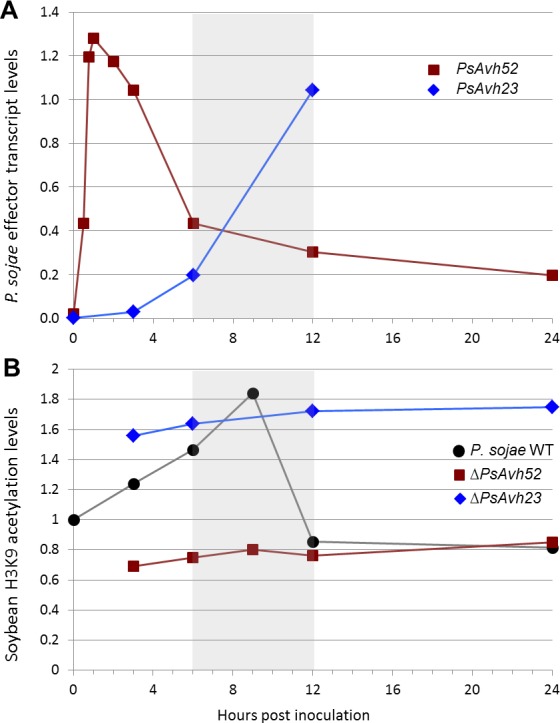
Expression patterns of PsAvh52 and PsAvh23 correlate with changes in soybean histone H3 acetylation during P.sojae infection.(A) Transcript levels of PsAvh52 and PsAvh23 relative to a basket of constitutive reference genes, during P. sojae infection of soybean hypocotyls. Data are adapted from Figure 5 of Wang et al., 2011 and Figure 8C of Ma et al., 2015. (B) Soybean histone H3K9 acetylation levels during infection of soybean hypocotyls by P. sojae wildtype P6497, and by strains carrying PsAvh52 and PsAvh23 deletions. Data are from Figure 5C of Kong et al., 2017 and Figure 6B of this publication. Shaded box indicates the time interval during which PsAvh23 transcript levels first exceed those of PsAvh52, and when H3K9 levels drop below pre-infection levels.